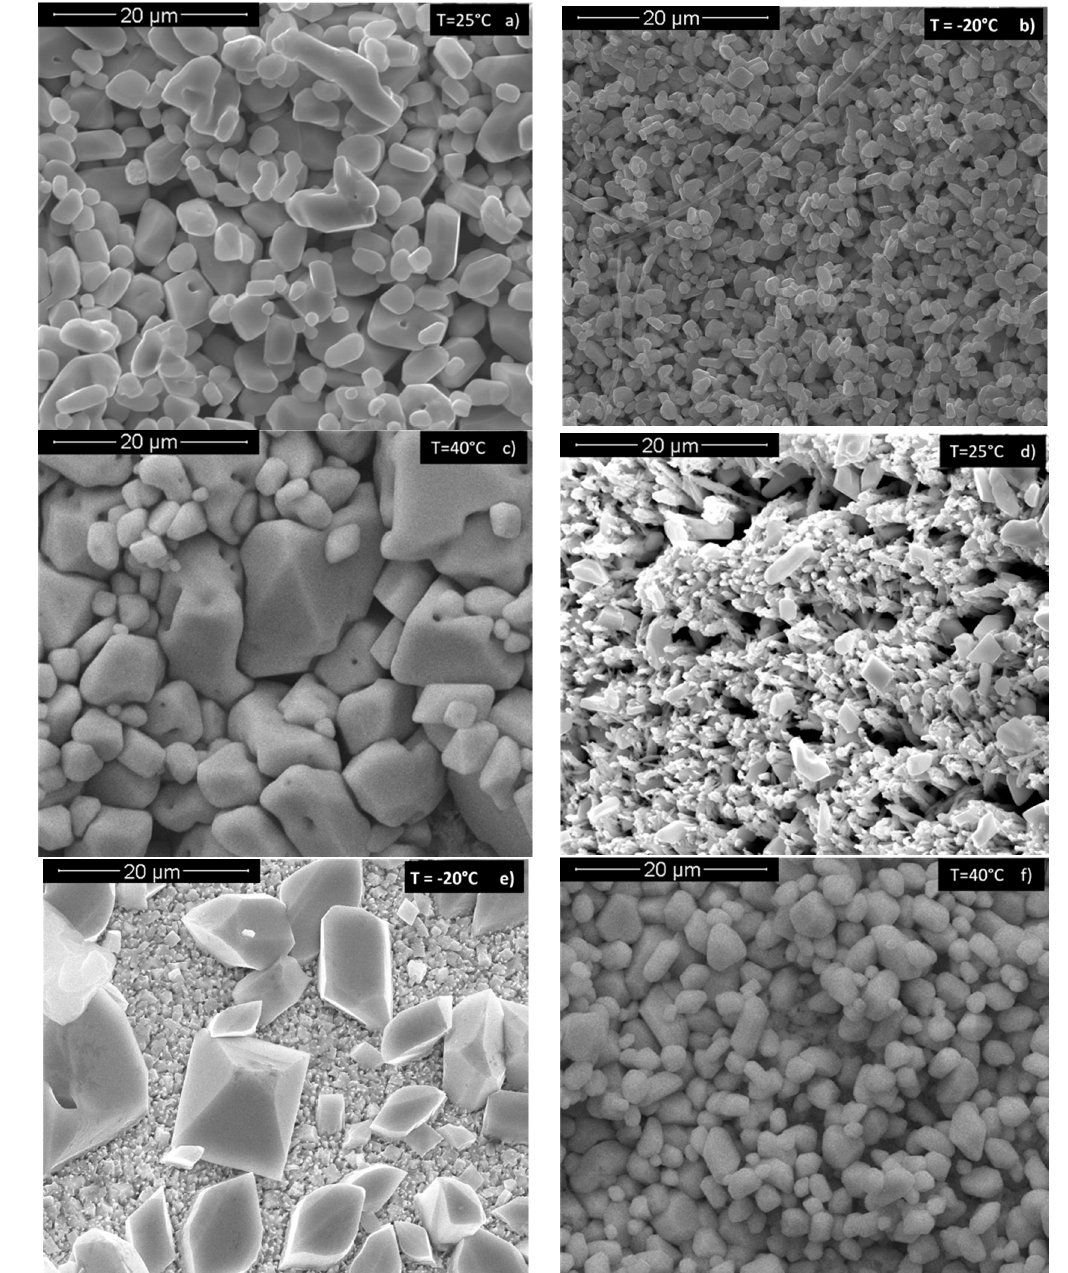
Figure 12. SEM images of Pb and PbO 2 NW electrode after 1000 cycles at 10 C: ( a ) Pb NWs T = 25 ± 2 °C; ( b ) Pb NWs T = − 20 ± 2 °C; ( c ) Pb NWs T = 40 ± 2 °C; ( d ) PbO 2 NWs T = 25 ± 2 °C; ( e ) PbO 2 NWs T = − 20 ± 2 °C; ( f ) PbO 2 NWs T = 40 ± 2 °C.